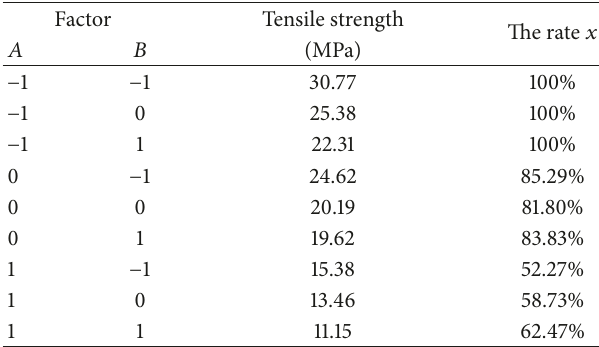
Table 3: The experiment results at different levels of layer thickness ( 𝐴 ) and velocity ( 𝐵